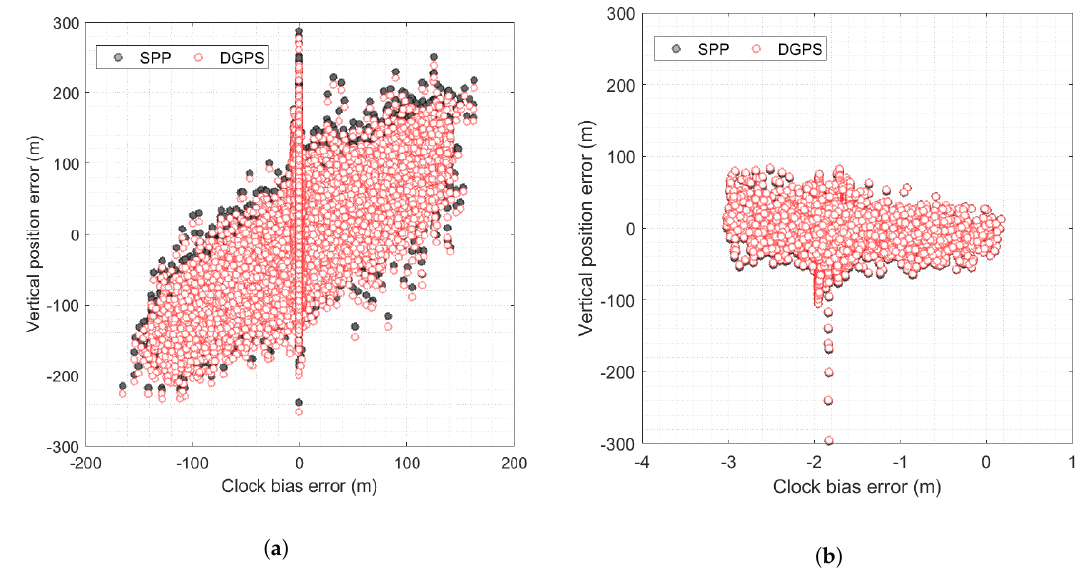
Figure 7. Vertical error versus clock bias error. Grey markers represent data for single point solution, while red circles represent data for the DGPS technique: ( a ) Steering on; ( b ) steering